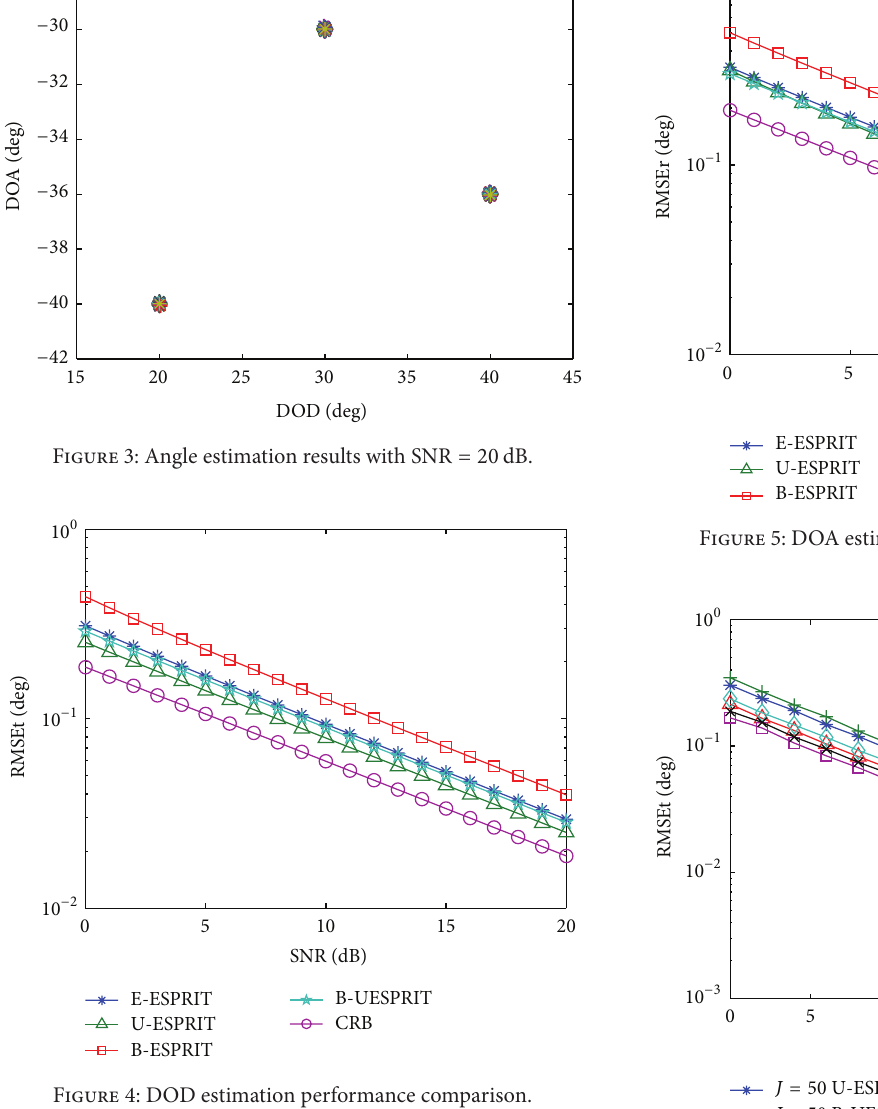
Figure 4: DOD estimation performance comparison.